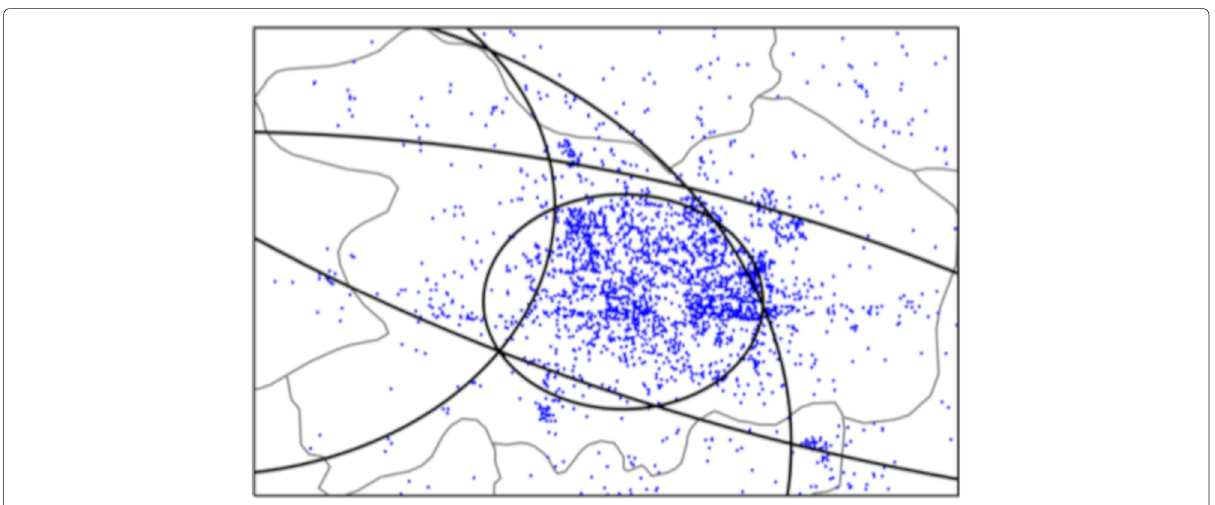
Fig. 1 An example of narrowed region using